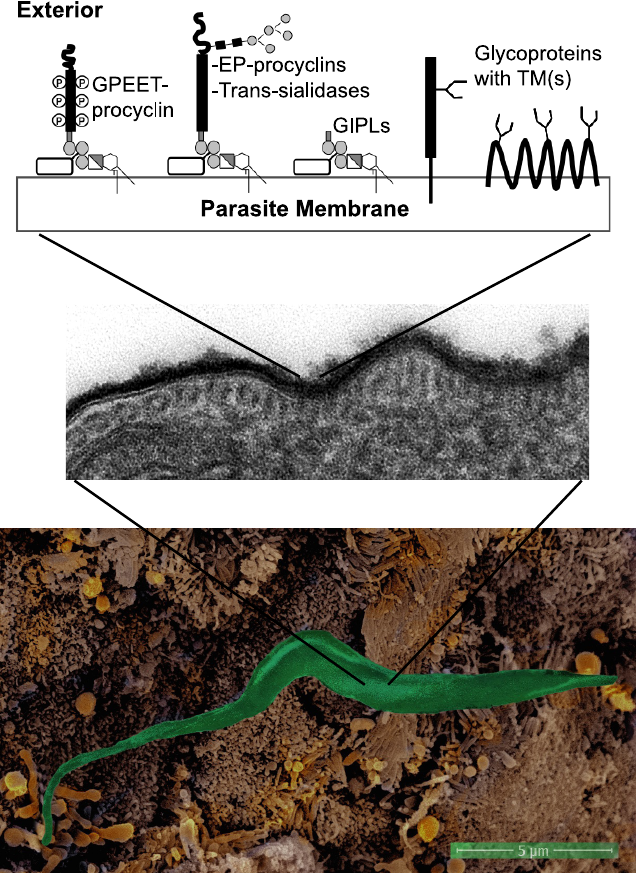
Fig 1. The surfaces of parasites, such as Trypanosoma brucei brucei , are covered by glycoconjugates forming a protective glycocalyx against the host defense systems. False-color scanning electron microscopy (EM) of a T . b . brucei procyclic interacting with cell microvilli in the tsetse fly proventriculus (bottom panel). Transmission EM of ruthenium-red stained ultrathin sections showing the surface glycocalyx of T . b . brucei procyclic cells (middle panel). Scheme summarizing the main surface glycosylphosphatidylinositol (GPI)-anchored (EP- and GPEET-procyclins and trans-sialidases)